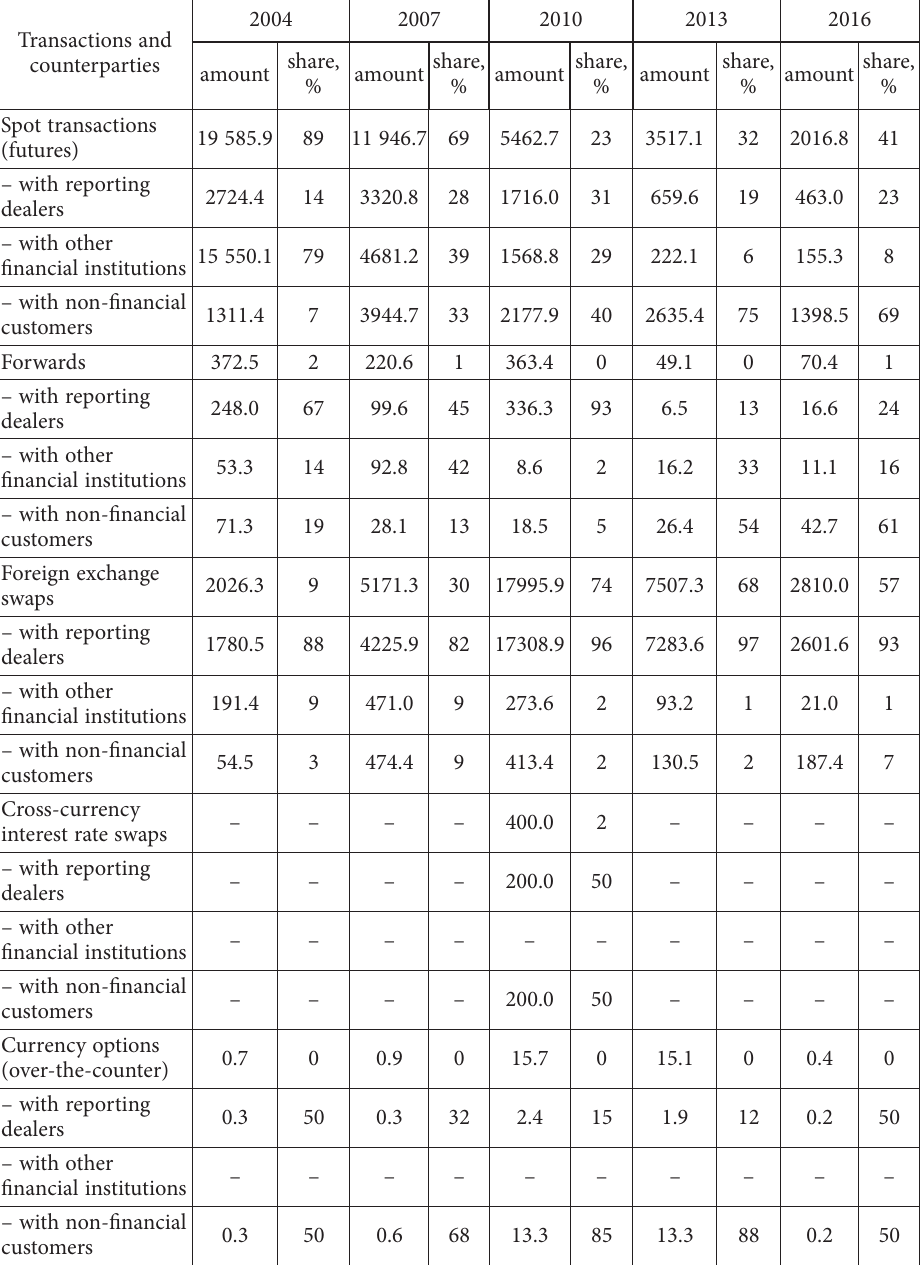
Table 1. Turnover in the Lithuanian foreign exchange market by transactions, counterparty and ma- turity (nominal or notional transaction amounts in April 2016; millions of U.S. dollars) (source: LB, 2016, 2018, 2019b; BIS, 2018a,